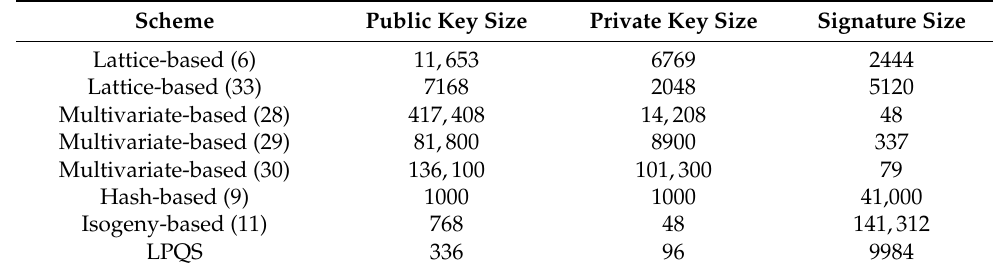
Table 2. Postquantum signatures scheme comparison in bytes with 128-bit quantum